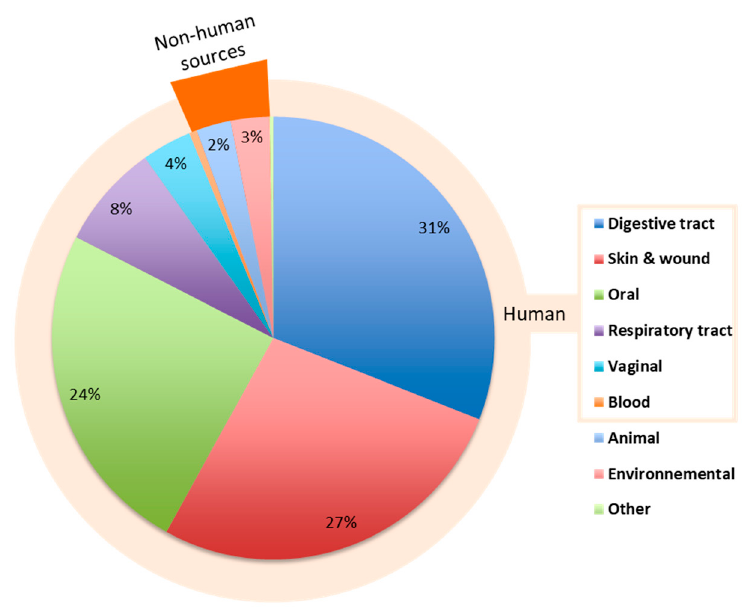
Figure 2. Relative distribution of 16S rRNA gene sequences corresponding to S. moorei ( ≥ 98.65% of sequence identity with the type strain) in the NCBI database ( n = 356) according to origin. Sequences in the “Blood” ( n = 2) and “Other” ( n = 2) categories each represent 0.56% of the 356 sequences.